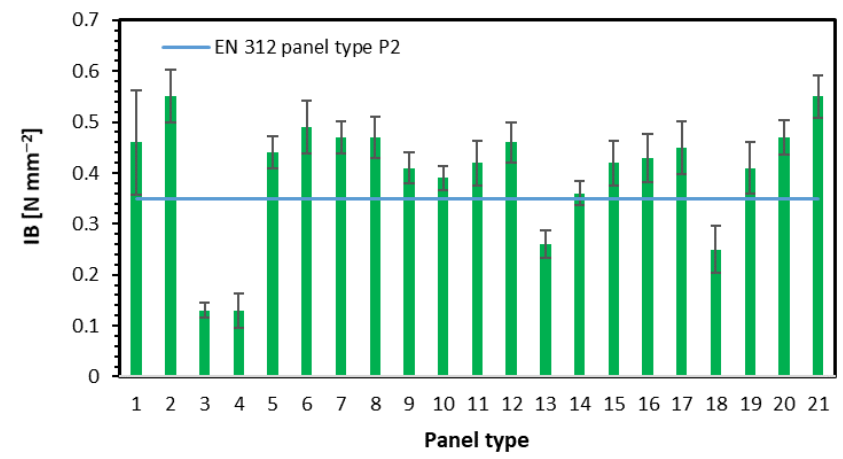
Figure 5. The internal bond of tested panels.